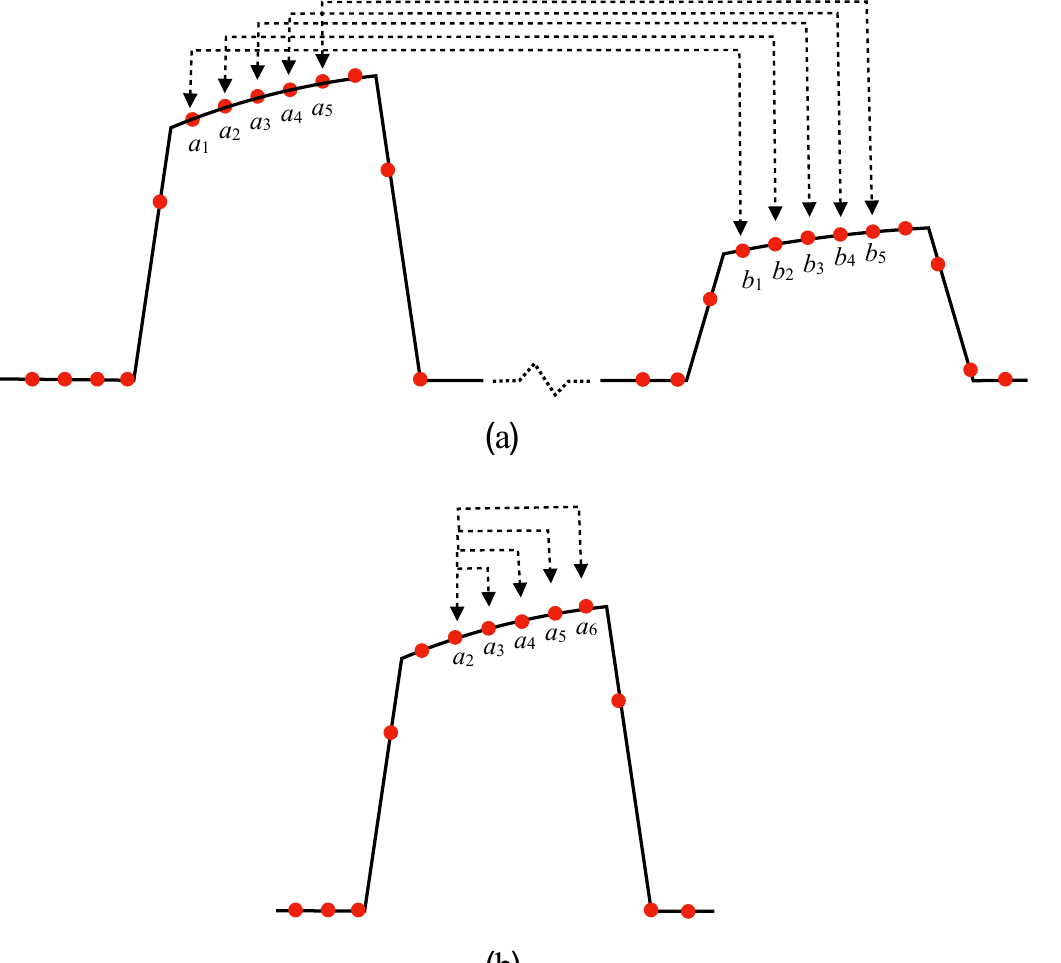
Figure 4. Digitized samples used for the measurements of S vs. the laser wavelength: ( a ) two-pulse scheme and ( b ) one-pulse